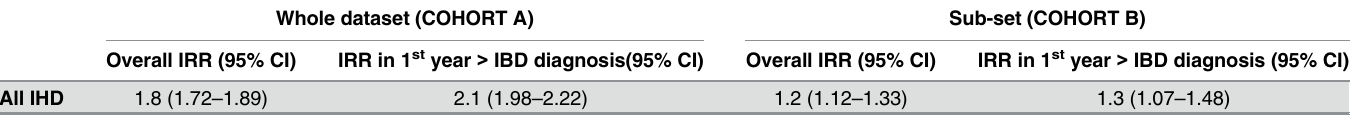
Table 6. Incidence Rate Ratios (IRR) comparing whole group analysis with sub-set *